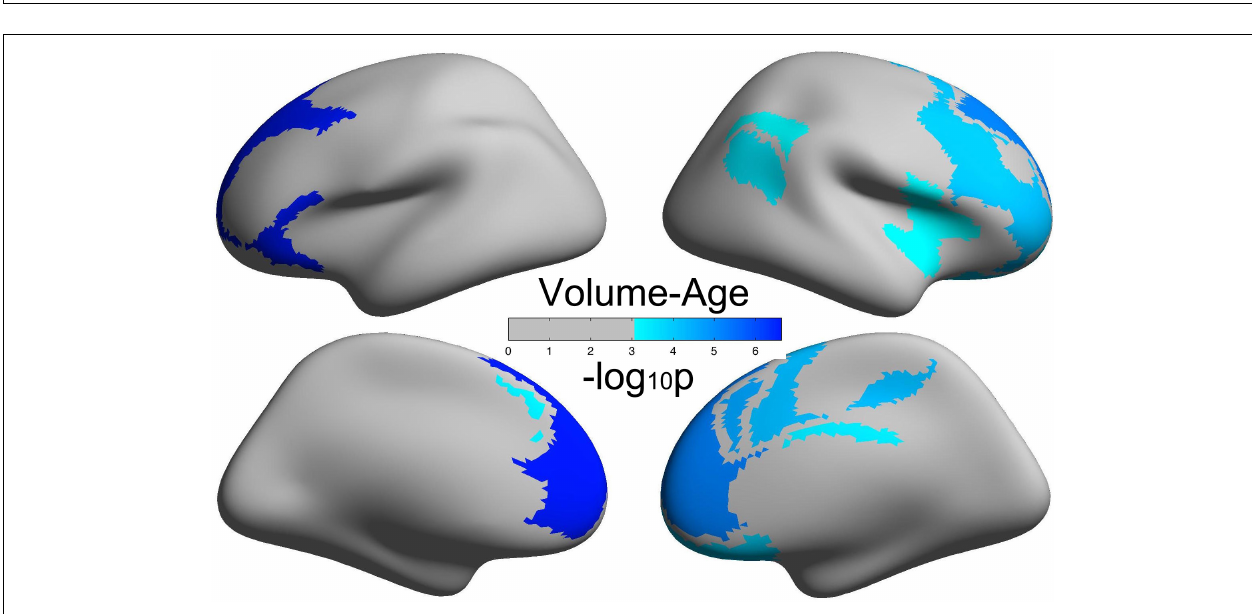
FIGURE 1 | All the five subscales of self-control increased with age. Blue, Impulse Control (A) ; red, Health Habit (B) ; green, Reject Temptation (C) ; purple, Job Focus (D) ; black, Control Entertainment (E) .